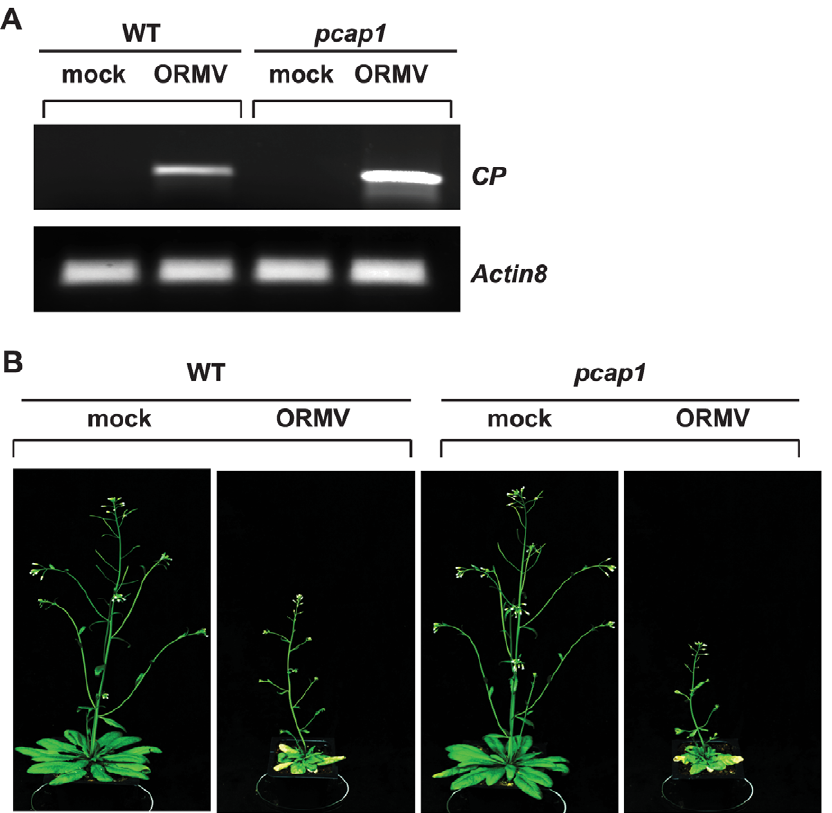
Figure 9. ORMV infection of wild type and pcap1Arabidopsis plants. (A) RT-PCR was used to determine the accumulation of plus-strand ORMV RNAs in upper uninoculated rosette leaves at 6 dpi (top panel). Actin8 was amplified as control (bottom panel). (B) ORMV infected plants (21 dpi). Wild-type (WT), PCaP1 knockout ( pcap1 ).